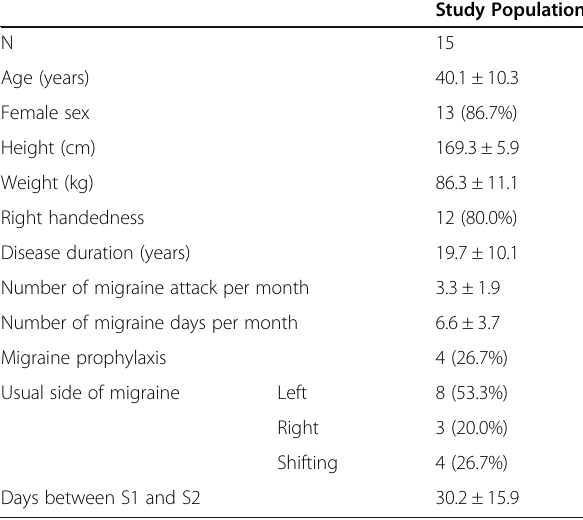
Table 1 Clinical and demographic features of study